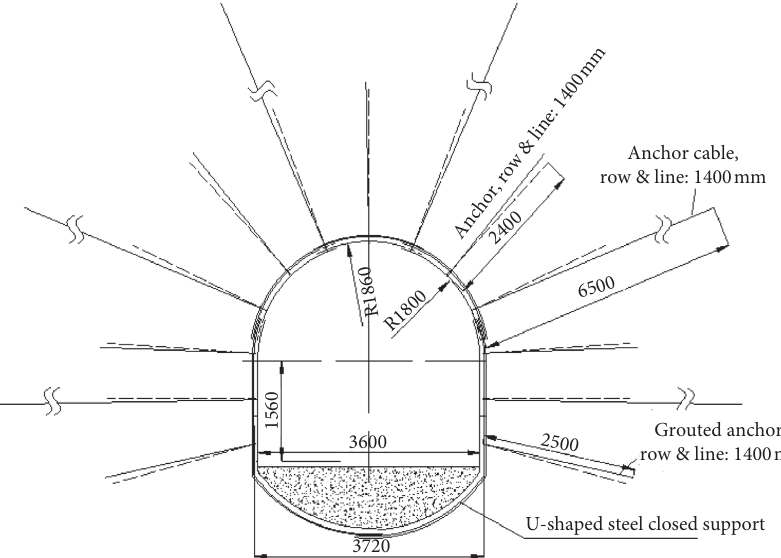
Figure 14: Roadway support design drawing.